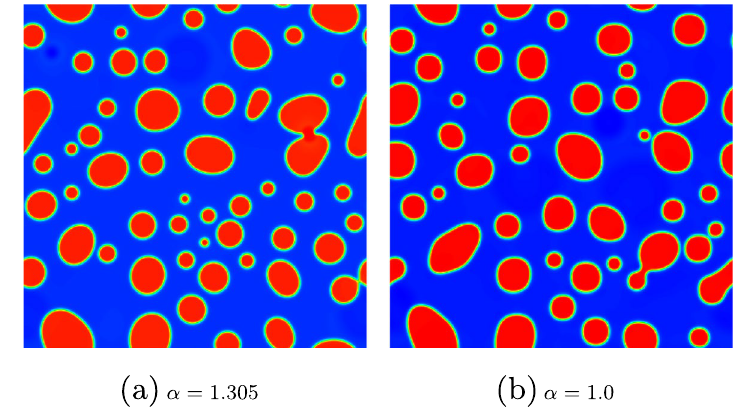
Fig. 13 Snapshots of the spinodal decomposition process, τ = 0.3 , T r = 0.8 , t = 4000